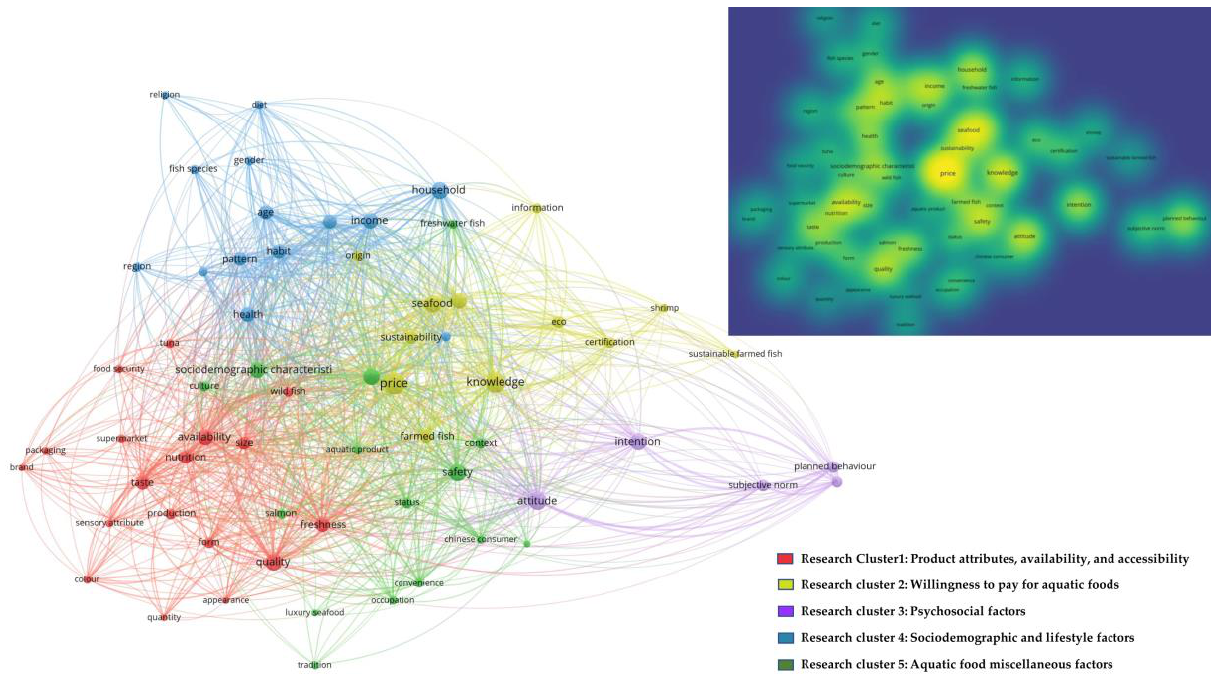
Figure 5. Map of research clusters detected by keyword co-occurrence and density visualisation. Text data (both title and abstract fields) of the identified publication was